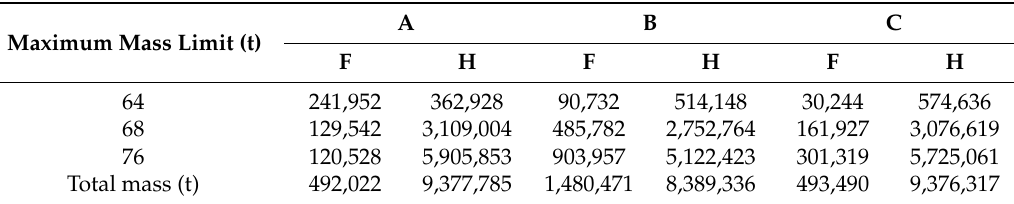
Table 3. The transportation quantities (RC) of the vehicle combinations (64, 68 and 76 t) due to three fleet-management methods for travelling on forest roads: A = 40, 4 and 2% for 64, 68 and 76 t, respectively; B = 15, 15 and 15%, respectively; and C = 5, 5 and 5%, respectively. F = forest roads and roads with speed <60 km/h, H = Highways and other roads with speed ≥ 60 km/h.